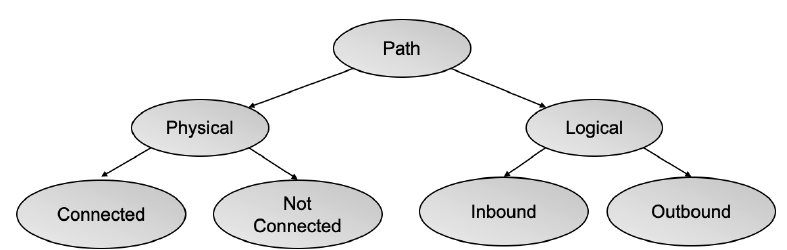
Figure 4. Delivery Paths’